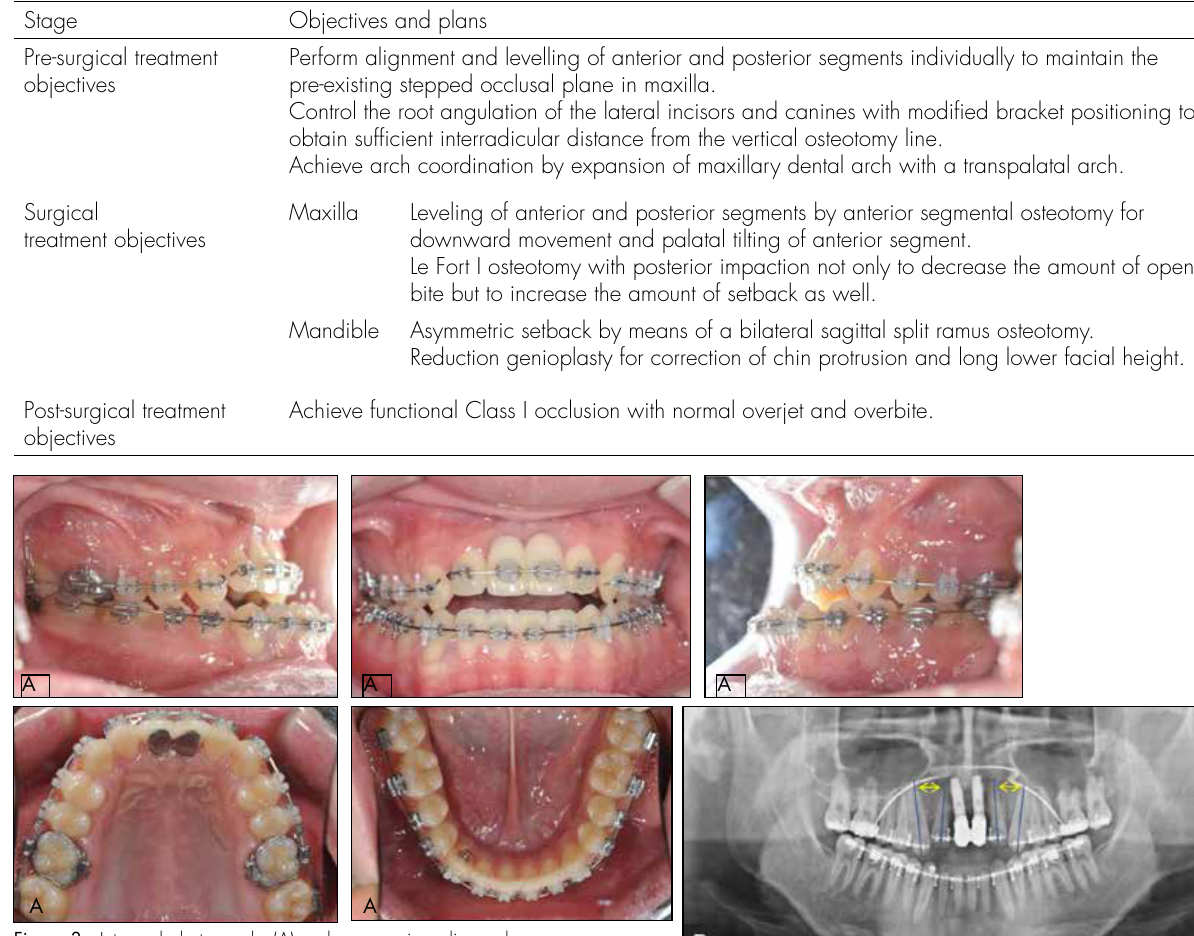
Figure 3. Intraoral photographs (A) and panoramic radiograph (B) at pre-surgical